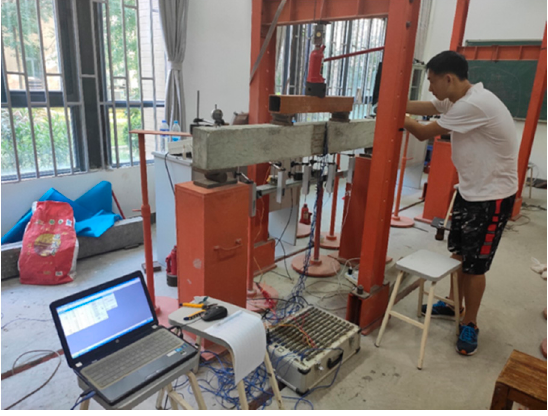
Figure 3. Laboratory static testing of the experiment beam. Materials 2020 , 13 , 1567